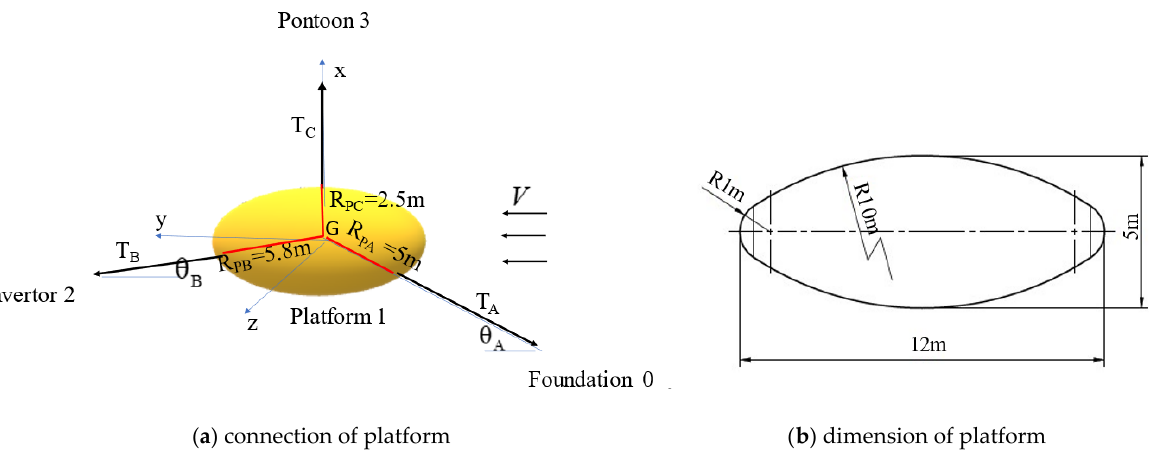
Figure 3. Configuration of the platform.